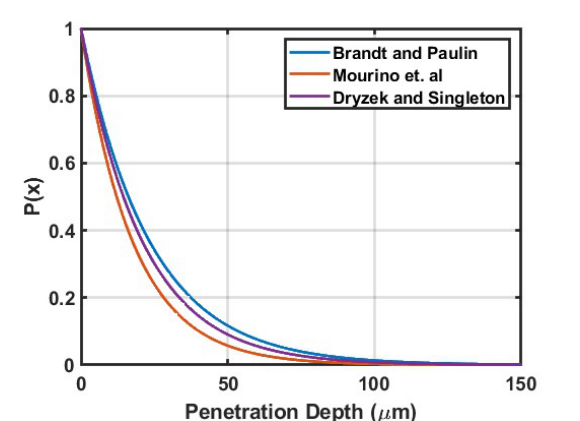
Figure 1. Probability functions for the implantation depths of positrons from a 22 Na source are plotted for the three linear absorption coefficients referenced from previous literature